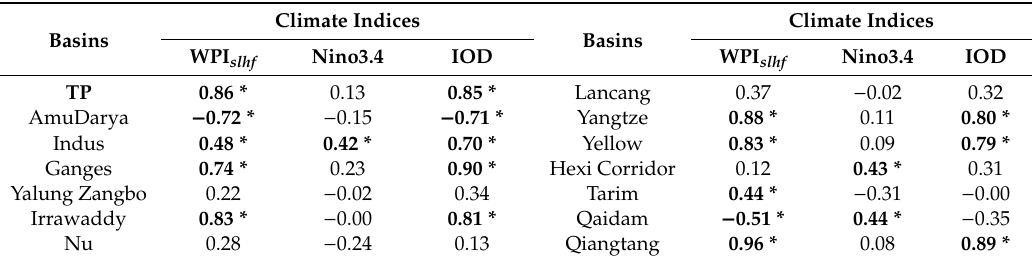
Figure 11. The time series of the Indian Ocean Dipole (IOD) index (shading and solid black line) and standard time series of the TP budget (dashed blue line) and WPI-slhf index (solid red line) obtained by applying an 11-year moving average. Table 3. The correlation coe ffi cients of the WVB of 13 basins within the TP and climate indices of the IPWP by applying an 11-year moving